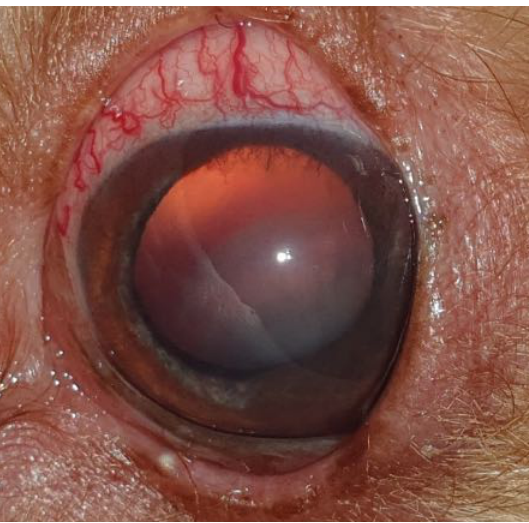
Figure 8. 8yo FN Miniature Poodle - posterior lens luxation and secondary glaucoma. Note the conjunctival hyperaemia, engorged episcleral vessels and the aphakic crescent dorsally indicating a posteriorly luxated lens. (North